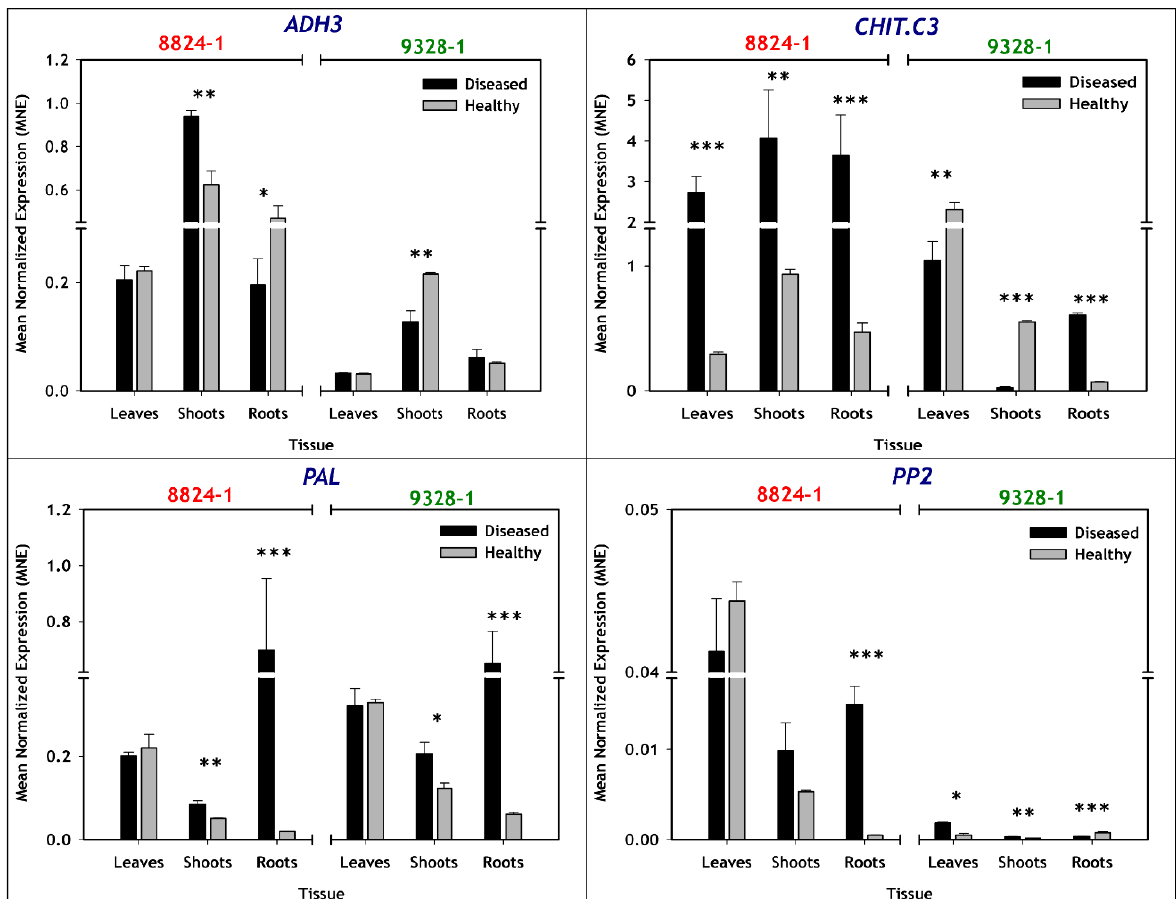
Figure 4. Bar plots representing relative expression of stress/defense-related genes ( ADH3 , CHIT.c3 , PAL and PP2 ) in leaves, shoots and roots of non-infected (grey) and PD-infected (black) pear selections 8824-1 and 9328-1. The data are expressed as mean normalized expression (MNE) against GAPDH , which is proportional to the relative quantity of mRNA in a given tissue. The MNE of each sample was determined from 3 biological replications with 2 repeats per biological replication. Asterisks indicate means that were significantly different (Tukey ’ s post hoc test, p < 0.05) with standard errors shown, and *, **, and *** indicating statistical significances of p < 0.05, p < 0.01, and p < 0.001, respectively.